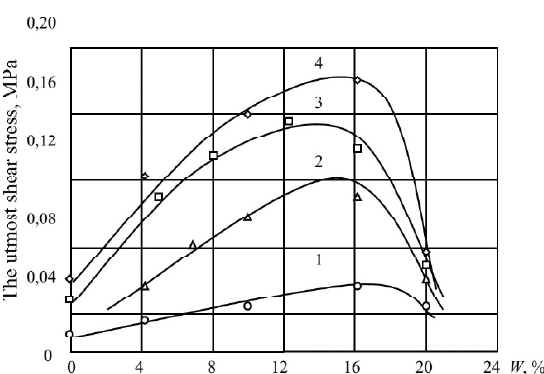
Fig. 7. Dependence of the utmost shear stress in pressed specimens of powder, obtained by spray drying of ceramic slurry, on humidity W and relative density of specimens 0.95 (1); 1.0 (2); 1.05 (3), and 1.1 (4) g/sm 3